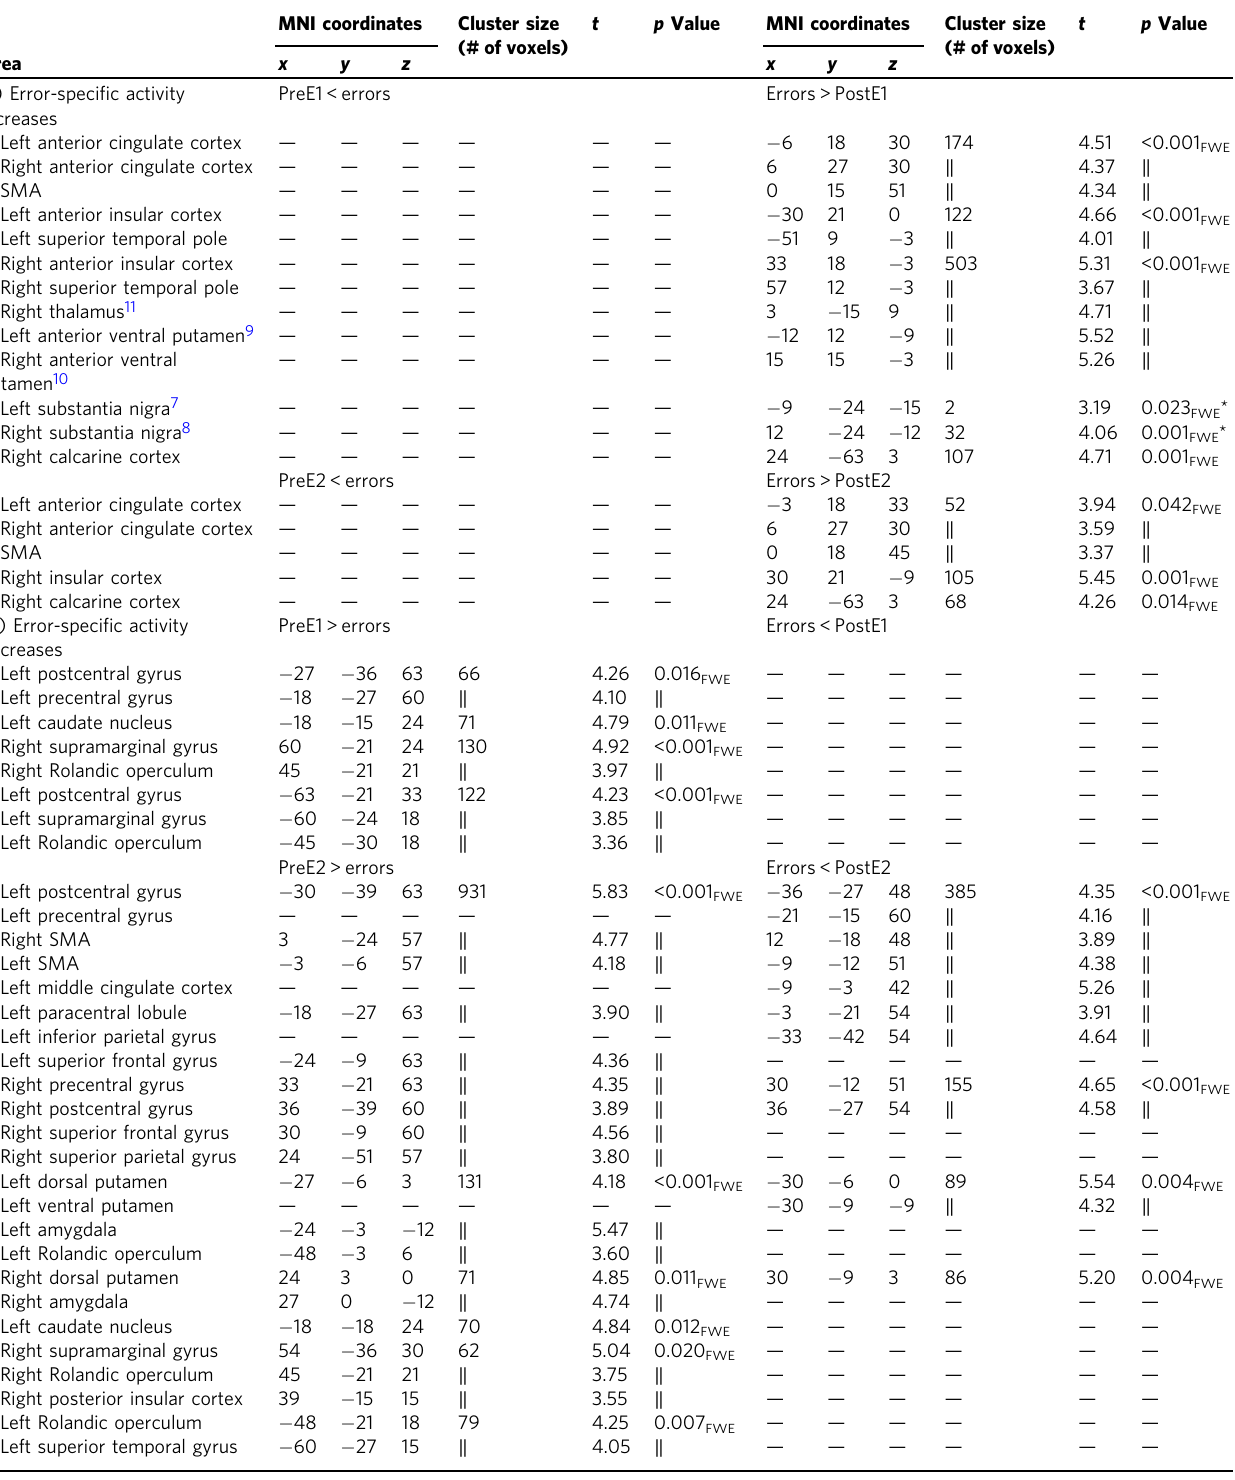
Table 2 Changes in activity immediately before and after errors.